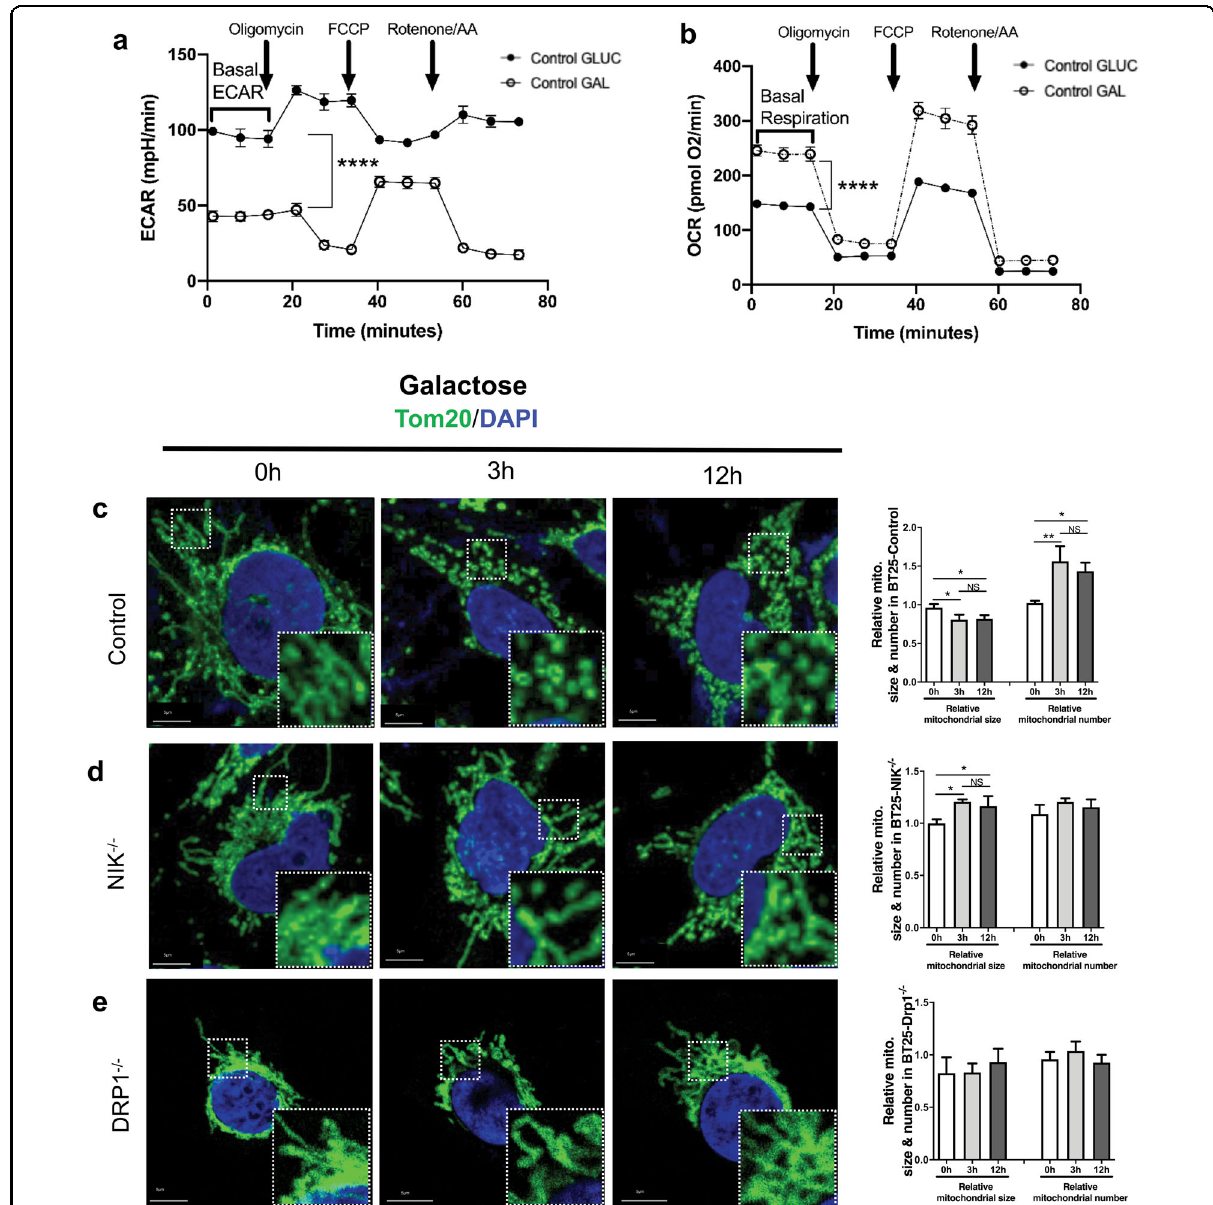
Fig. 2 Metabolic shift from glycolysis to OXPHOS triggers NIK-dependent mitochondrial fi ssion. a Representative Seahorse XF Cell Mito Stress test showing extracellular acidi fi cation rate (ECAR) of BT25 control cell in glucose and galactose media. Bracket indicates signi fi cance between basal ECAR between the conditions. Student ’ s t test (paired, two tailed) p < 0.0001. b Change in O 2 consumption rate (OCR) plotted as pmol O 2 per minute. Brackets indicate signi fi cantly different basal respiration. Student ’ s t test (paired, two-tailed) p < 0.0001. c – e Representative confocal images of BT25 control, NIK − / − , and DRP1 − / − cells grown in 18 mM glucose and shifted to 18 mM galactose for the indicated time points and immunostained with a Tom20-FITC-conjugated antibody. Areas marked with white squares are ampli fi ed and shown in the insert. Scale bar, 5 μ m. DRP1 knockdown was veri fi ed by immunoblot (Supplementary Fig. 4) and NIK − / − cells were described previously 20 . Quanti fi cation of mitochondria size and number of control, NIK − / − , and DRP1 − / − cells pictured to the right of each image respectively. Mitochondria was quanti fi ed using Image J and signi fi cance was determined by one-way ANOVA followed by Tukey post-hoc analysis ( n ≥ 30 cells per cell condition); * p < 0.05, ** p < 0.01, ns: not signi fi